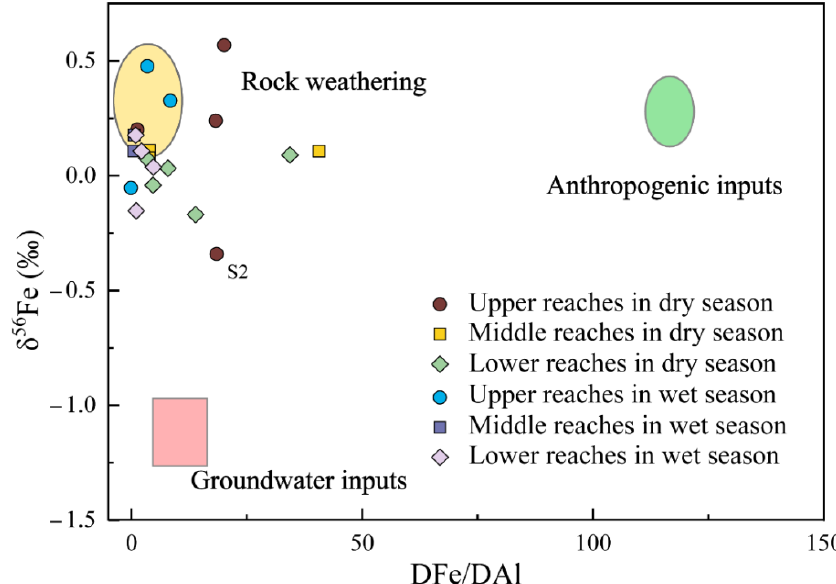
Figure 7. δ 56 Fe versus DFe/DAl ratio in Mun River showing the source of dissolved Fe. The data of end-members of rock weathering and anthropogenic inputs are from [40] and those of end-member of groundwater inputs are from [61,65] .